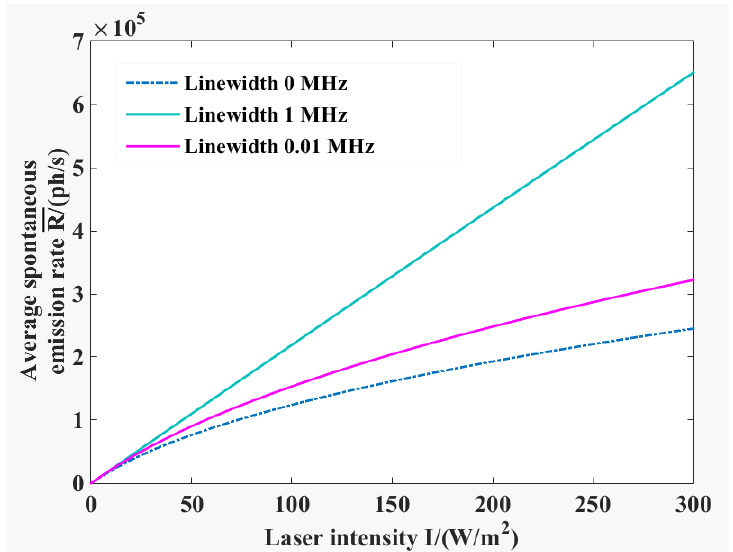
Figure 11. Average spontaneous emission rates vs. intensity at δ v L